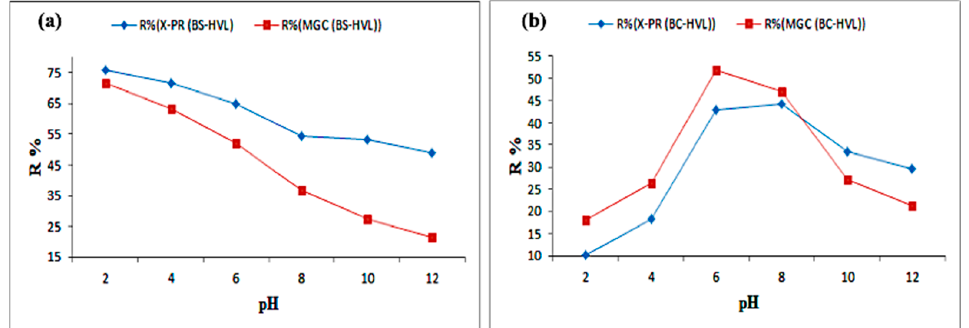
Figure 11. ( a , b ): Effect of pH on the adsorption of dyes X-PR and MGC by BS-HVL and BC-HVL (t = 90 min; T = 21 ± 1 °C; m ad = 50 mg; C o = 50 mg L − 1 and stirring speed 150 rpm).